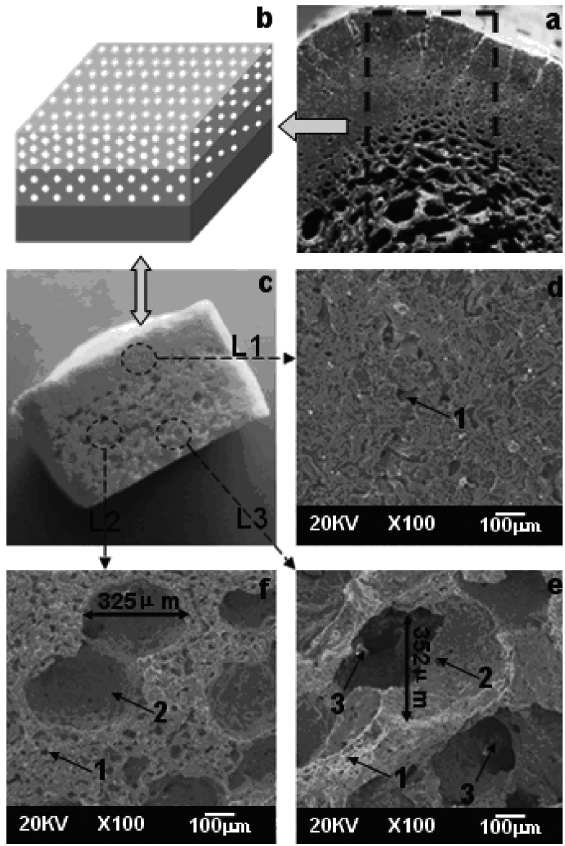
Fig. 1 – The porosity-graded calcium polyphosphate scaffold prepared in this paper. (a) the functionally graded structure of a natural bone, (b) the schematic representation of an artificial scaffold, (c) the photograph of the scaffold, (d)-(f) SEM pictures of different